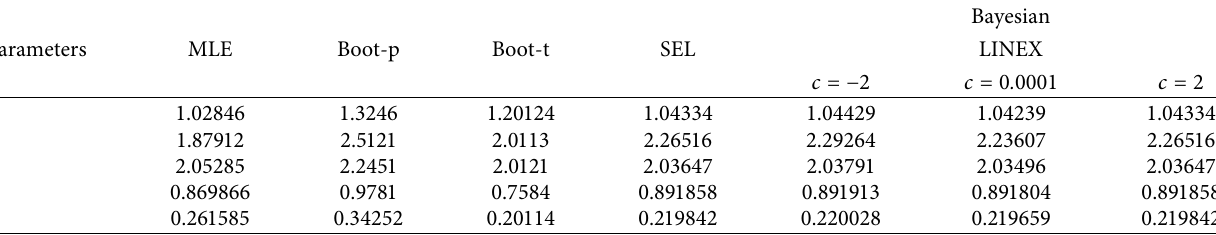
Table 2: Point estimates for the parameters, reliability, and hazard functions.